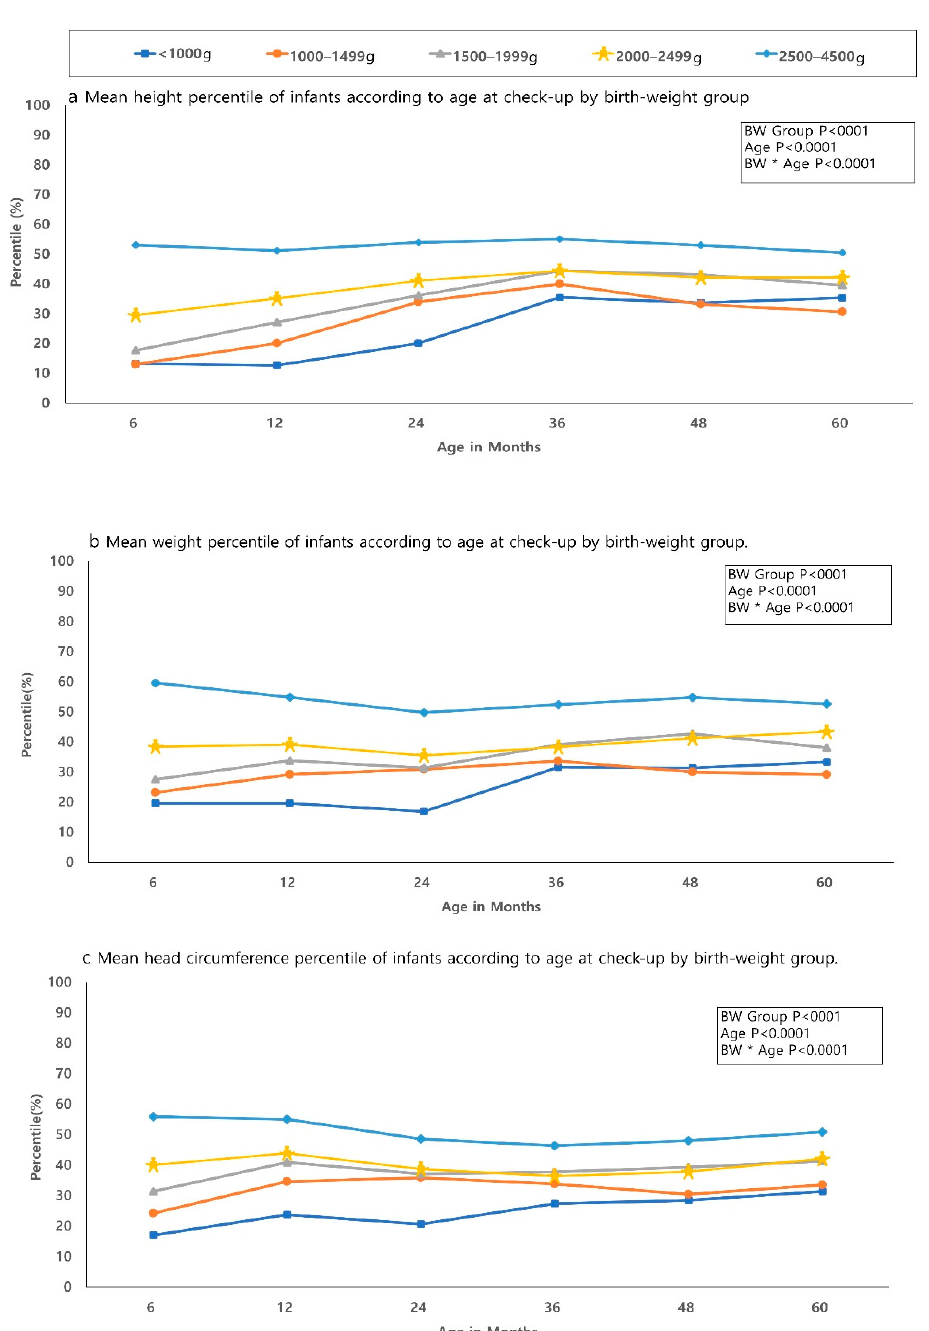
Figure 1. Mean growth percentile of infants according to age at check-up by birth-weight group. ( a ) Height. ( b ) Weight. ( c ) Head circumference (HC). Significant differences in height, weight, and HC between the low birth weight infants groups and the reference group according to age at health checkup were shown. p -values were significant in height, weight, and head circumference between each low birth weight group and the reference group compared at age of health check-up.